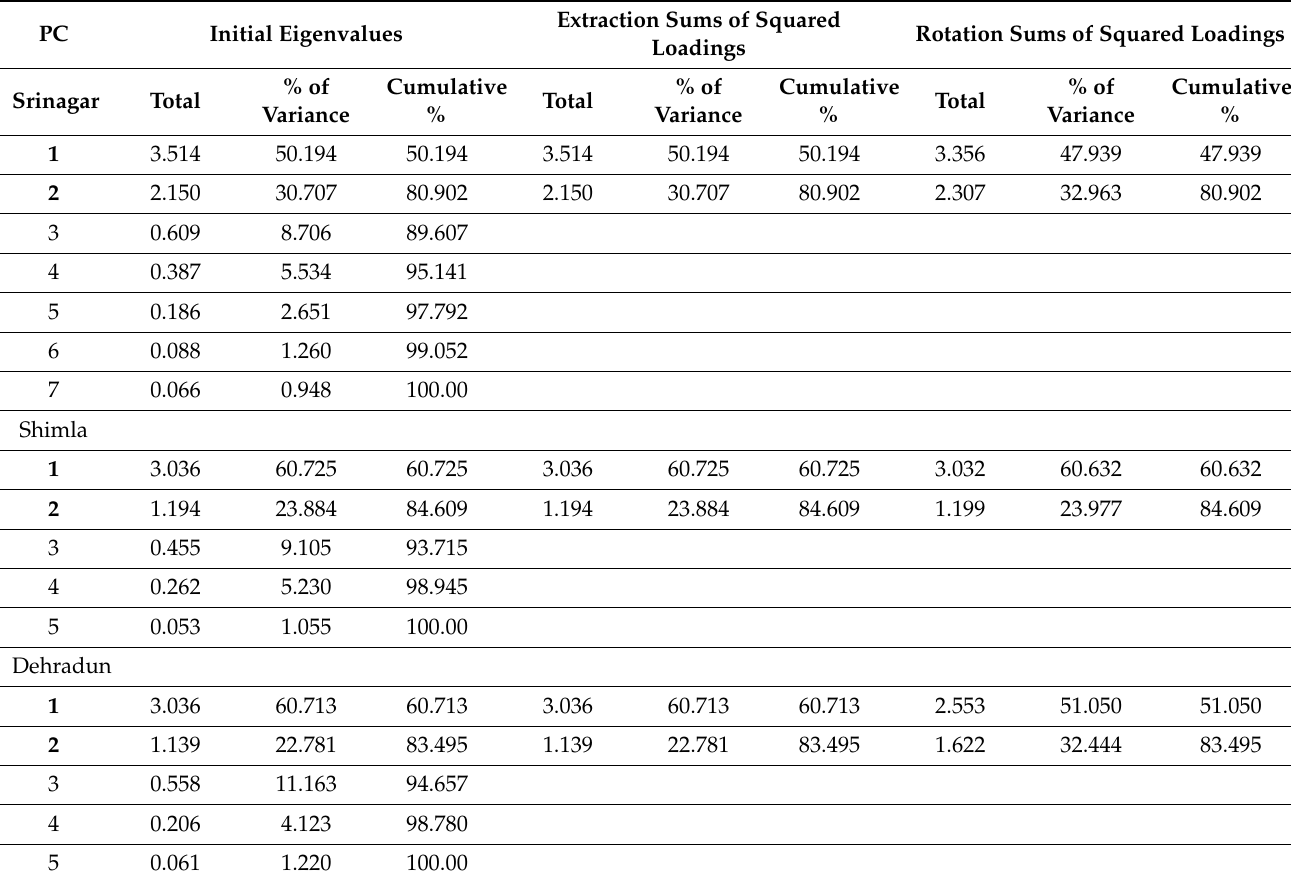
all the cities are shown in Table 3. Table 2. PCA with Varimax rotation shows the amount of variance explained by principal components (PC) with above 1 Eigen value (in bold) for the three